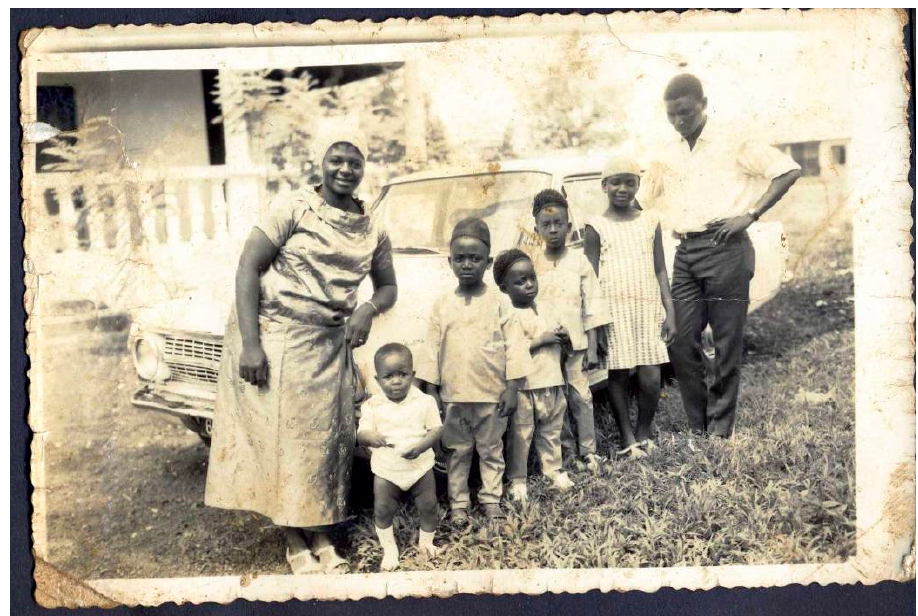
Figure 2. Benedicta and her family in Bamenda valorizing their newly acquired car.